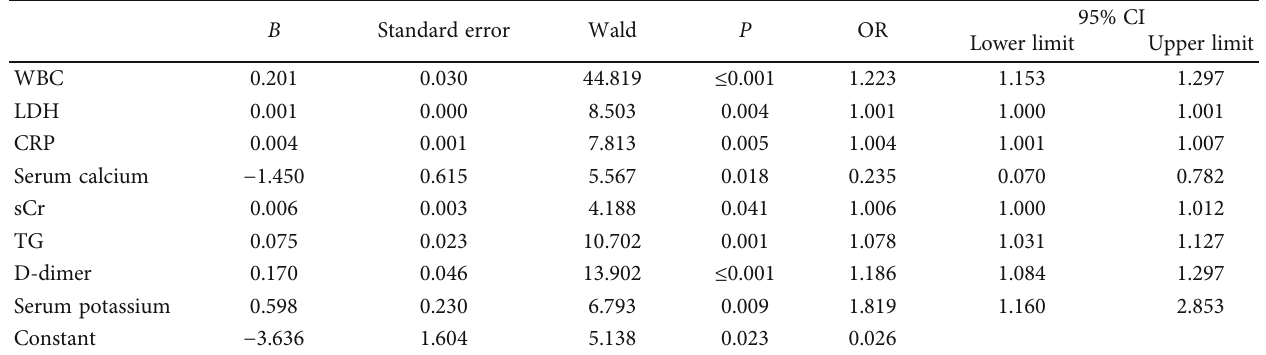
Table 3: Logistic regression analysis of independent prognostic factors in MSAP and SAP.